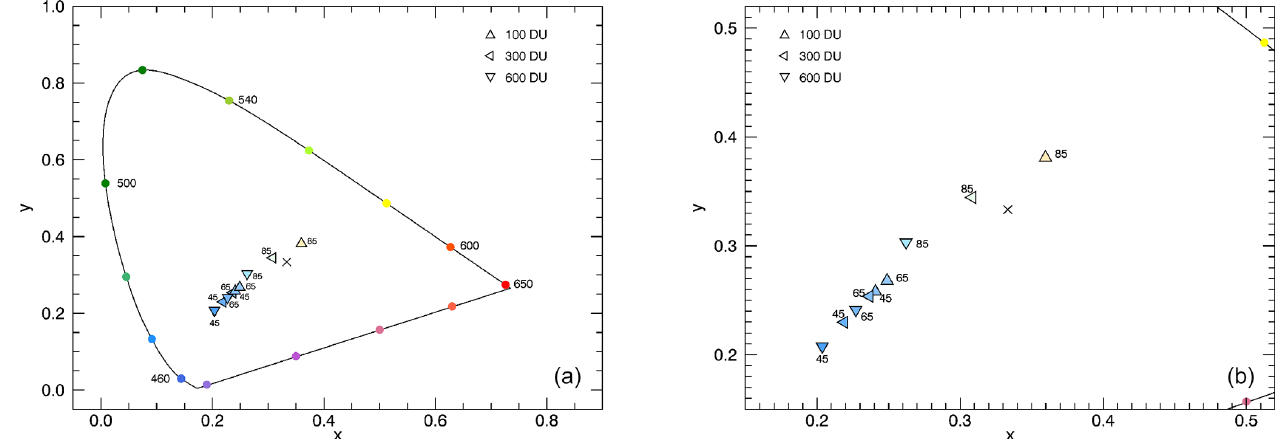
Figure 7. CIE chromaticity diagram for spectra including NLCs and different ozone column densities. Marked at the data points are the following: VZAs = 45, 65 and 85 ◦ , with SZA = 98 ◦ and SAA = 0 ◦ . The NLC parameters are as for the left panel of Fig. 3, i.e. r m = 50nm, S = 1 . 4, τ NLC = 10 − 4 and z NLC = 82km. Panel (b) shows an enlarged version.